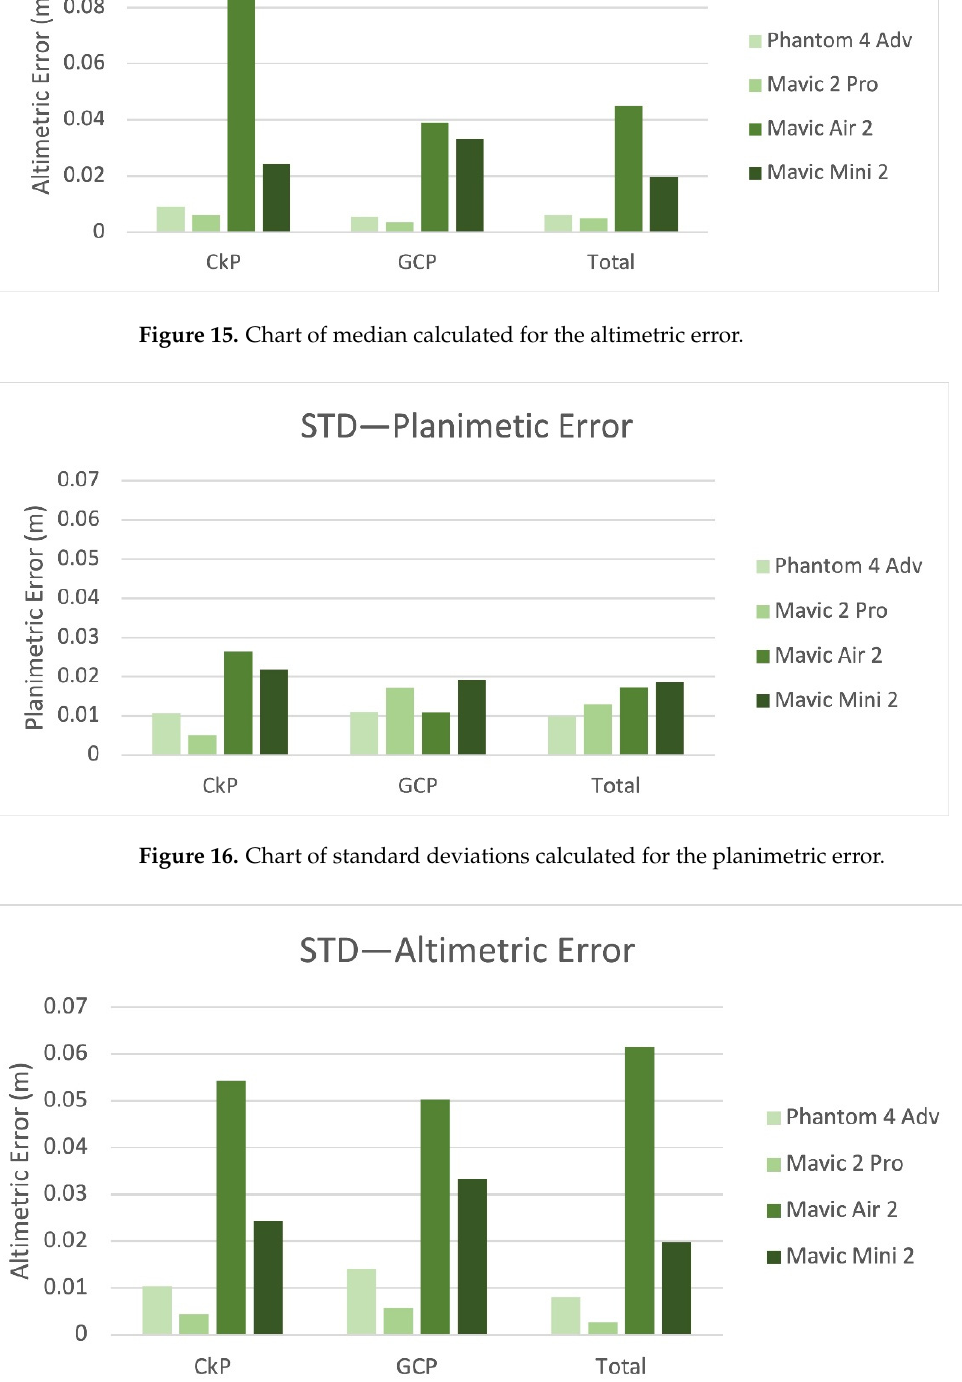
Table 13. Planimetric graphic errors when performing flights at different AGLs.